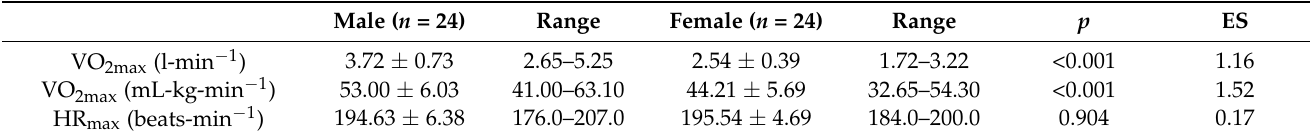
Table 2. Ergospirometric values obtained in the maximum incremental test.